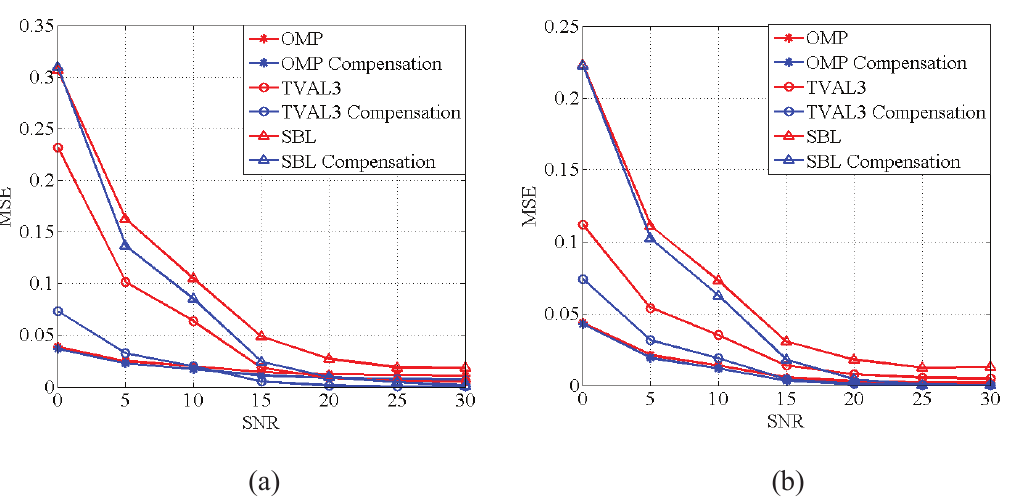
Figure 7. MSE performance of two targets under different SNRs ( a ) sparse target ( b ) extend